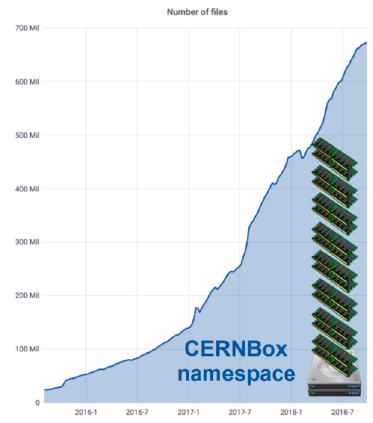
Figure 3: CERNBox namespace